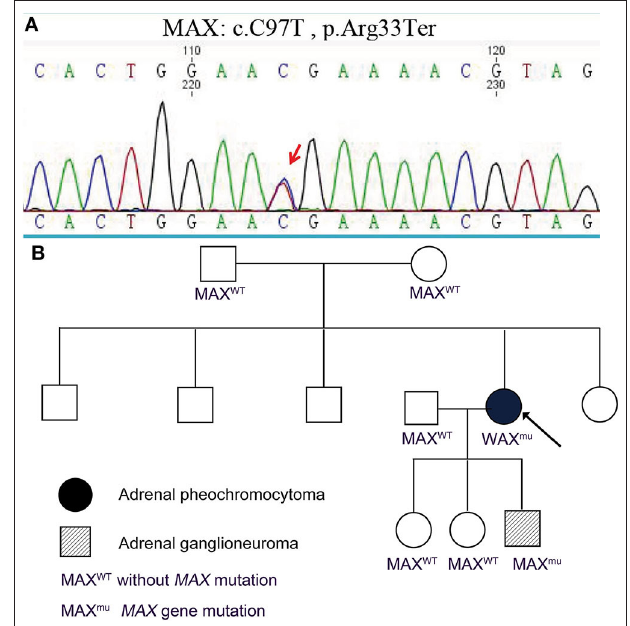
FIGURE 3 | Germline pathogenic MAX variants in this family. (A) Genetic testing indicated that the proband and her son had a germline pathogenic MAX variant (c.C97T, p.Arg33Ter). (B) Pedigree of a family with PCC and GN. Other familial members including parents of the proband, her husband, and two daughters did not have MAX variants.